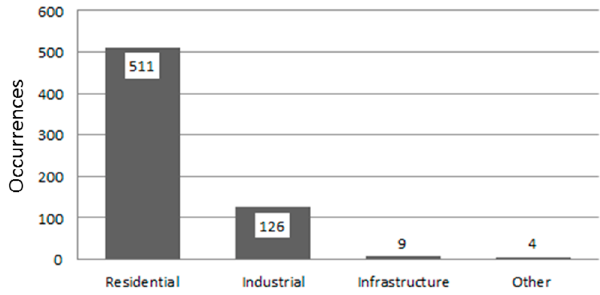
Figure 7. Number of changes detected per LU class.